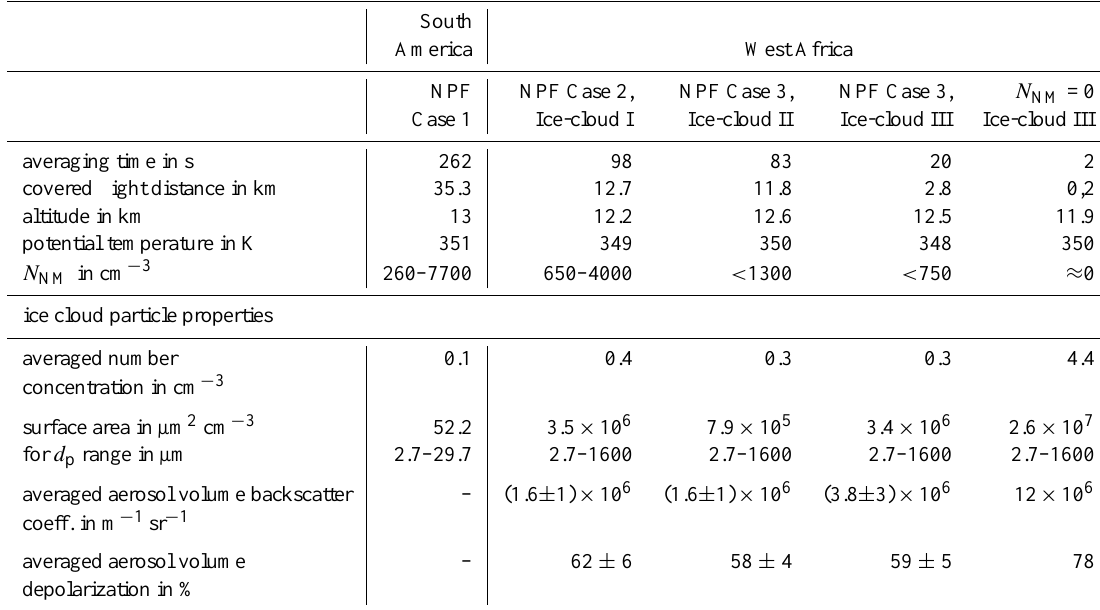
Table 3. Ice cloud microphysical parameters for the cloud events during NPF observation measured on board the M-55 Geophysica by the FSSP-100 and the CIP as well as the cloud particle volume backscatter coefficient and depolarization measured by the MAS instrument (SCOUT-AMMA). Note that the last column refers to the cloud parameters when nucleation mode particles fully